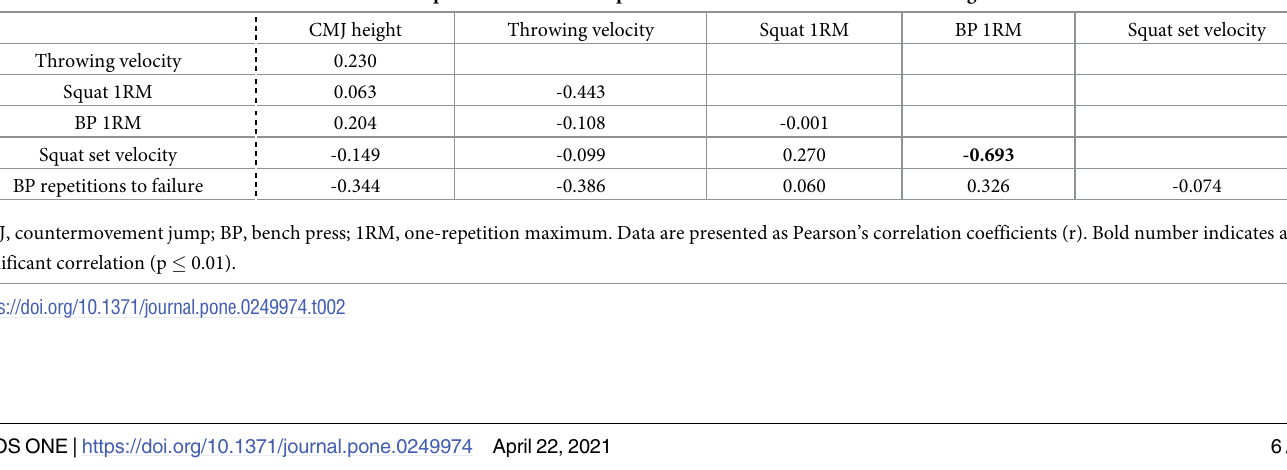
Table 2. Associations between the different tests for the percent differences in performance observed between both testing sessions.